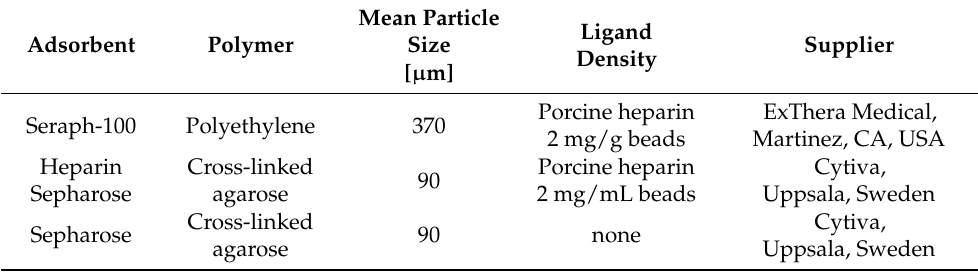
Table 1. Adsorbent characteristics.